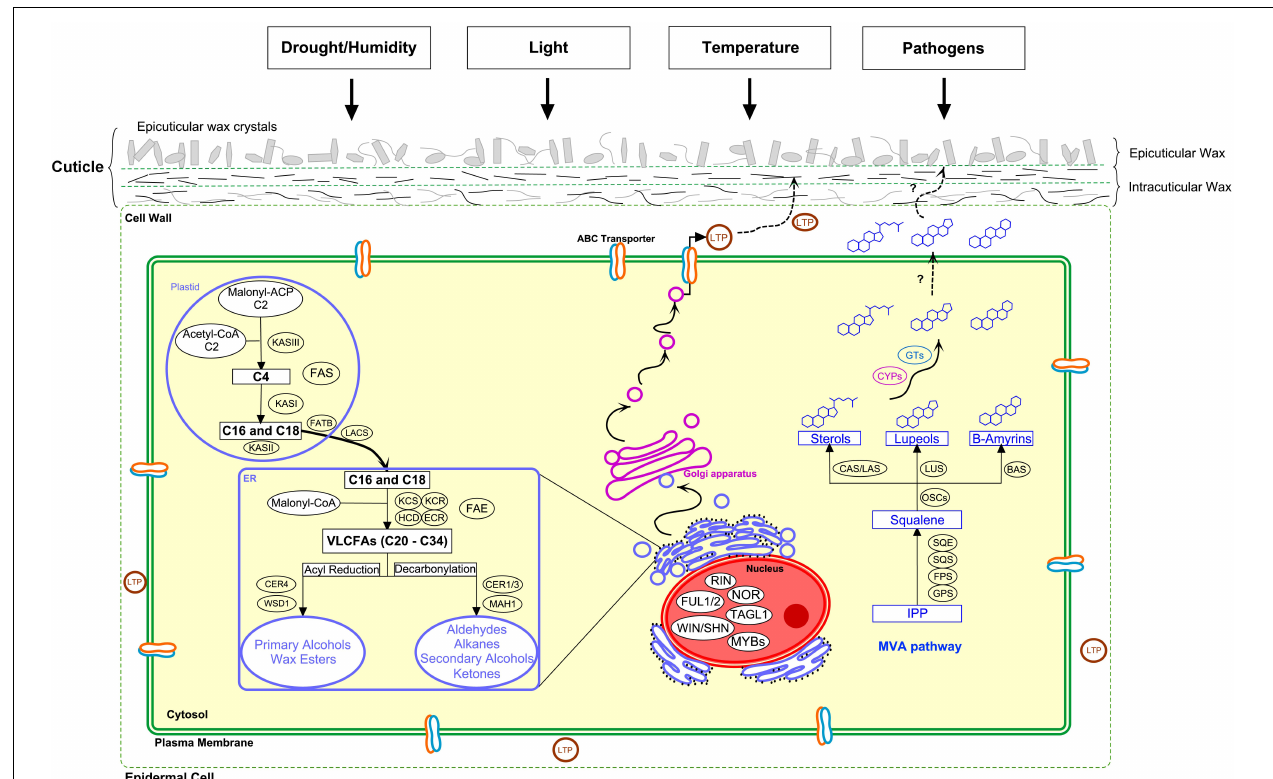
FIGURE 1 | Cuticular wax biosynthesis and interacting environmental factors. Cuticle has an important role as water barrier and in environmental interactions. Biosynthesis of aliphatic wax compounds starts with the generation of fatty acids in plastid by fatty acid synthase complex (FAS). The C 16 and C 18 precursors are hydrolyzed by acyl-ACP thioesterase (FATB) and converted to CoA thioesters by long chain acyl-CoA synthase (LACS) before transferred to endoplasmic reticulum (ER). In the ER, fatty acids are extended to very-long-chain fatty acids (VLCFAs) by fatty acid elongase (FAE) complex enzymes β -ketoacyl-CoA synthase (KCS), β -ketoacyl-CoA reductase (KCR), β -hydroxyacyl-CoA dehydratase (HCD), and enoyl-CoA reductase (ECR). VLCFAs are modified to primary alcohols by fatty acyl-CoA reductase (CER4) and further to wax esters by wax synthase (WSD1) through acyl reduction pathway. Decarbonylation pathway produces aldehydes, alkanes, secondary alcohols and ketones by enzymes including fatty acyl-CoA reductases (CER1/3) and a midchain alkane hydroxylase (MAH1). The compounds are transported to the plant surface through Golgi network and ABC transporters and by lipid transfer proteins (LTPs). Wax triterpenoids and sterols are derived from squalene that is produced from isopentenyl diphosphate (IPP) through mevalonic acid (MVA) pathway by geranyl pyrophosphate synthase (GPS), farnesyl pyrophosphate synthase (FPS), squalene synthase (SQS), and squalene epoxidase (SQE). Squalene is cyclized by oxidosqualene cyclases (OSCs) including cycloartenol synthase (CAS), lanosterol synthase (LAS), lupeol synthase (LUS), and β -amyrin synthase (BAS) to produce sterols, lupeols, and amyrins, respectively, which are modified by cytochrome P450 monooxygenases (CYPs) and glycosyltransferases (GTs) before transported to plant surface. TFs important for cuticle development are shown in the nucleus. Modified according to Kunst and Samuels (2009); Sawai and Saito (2011); Lee and Suh (2013); Yeats and Rose (2013); and Thimmappa et al.